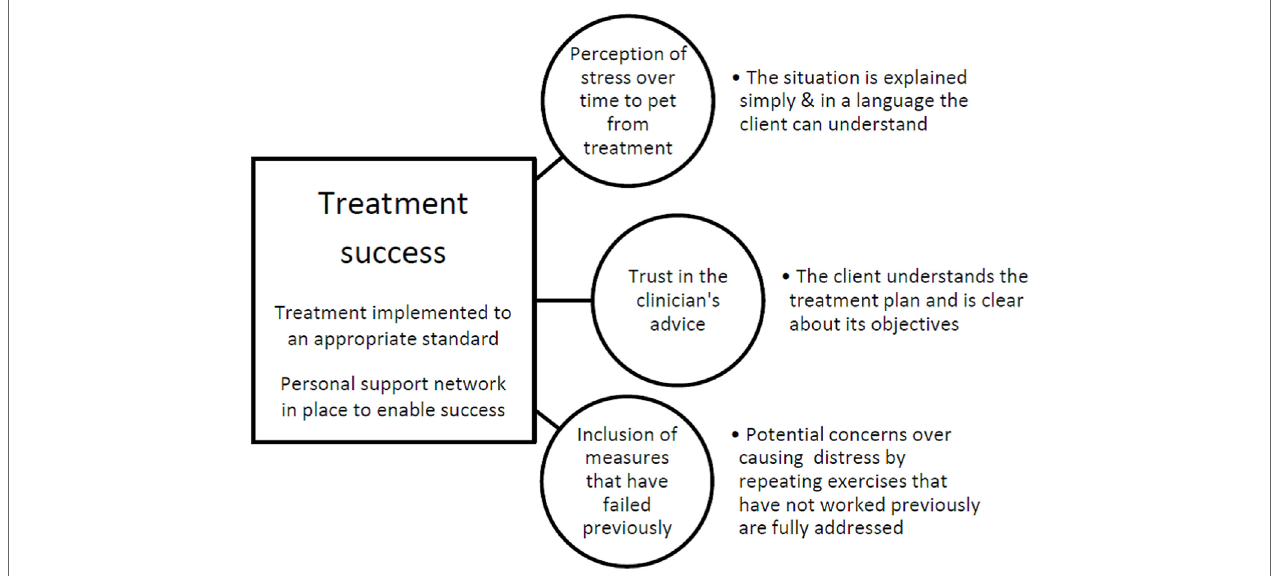
FigUre 2 | A graphical representation of postulated relationships within the caseload used in this study, illustrating points of variability associated with success. Treatment success (apparently defined by the appropriate implementation of the recommended treatment and the presence of personal support networks enabling the implementation of the treatment plan) is predicted by three key adherence factors (circles), and bullet points refer to other adherence factors that might help to mitigate against these